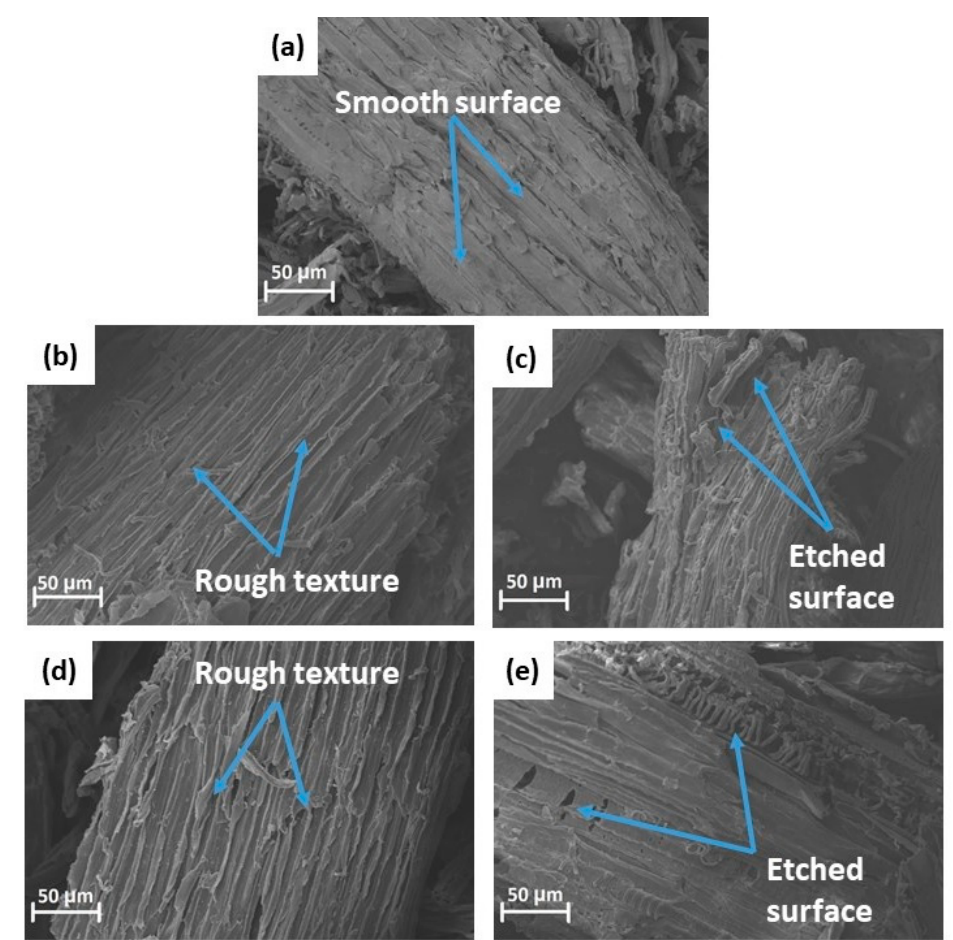
Figure 2. SEM micrographs of untreated hemp hurd powder ( a ), treated hemp hurd powder exposed to one and three cycles of alkaline treatment ( b and c , respectively), and hemp hurd powder exposed to one and three cycles of alkaline/peroxide treatment ( d and e , respectively).